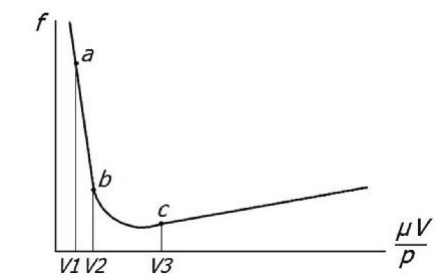
Figure 2. Top view of micro grooves – metal outflows on the edges, b = 0.5 mm